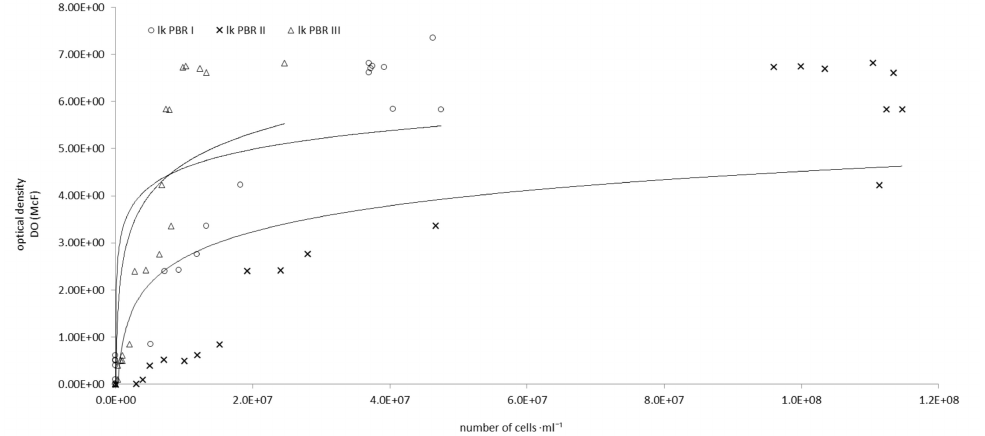
Figure 7. Correlation of the optical density of C. vulgaris cultures and number of cells for di ff erent lighting systems. Source: own